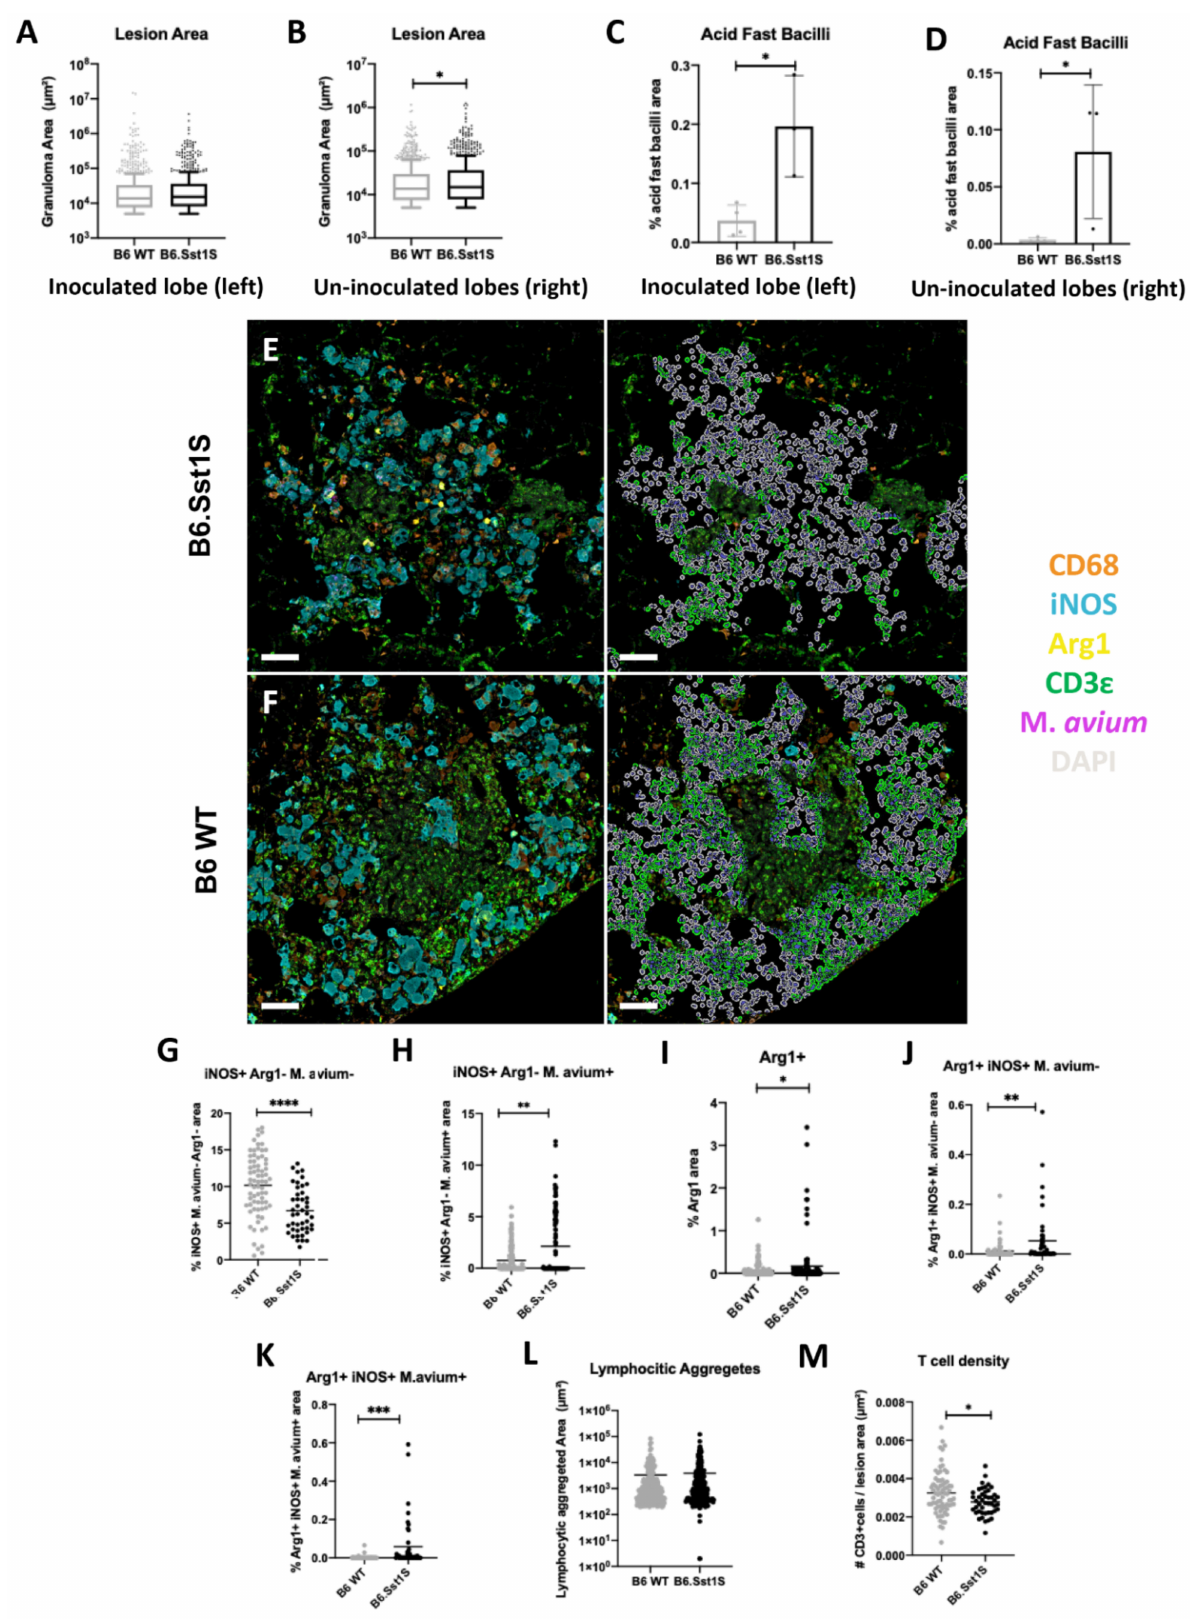
Figure 6. Comparison of immunopathology in inoculated ( left ) and un-inoculated lung lobes ( right ) from M. avium inoculated B6 WT compared to B6.Sst1S at 16 weeks-post infection (wpi) and the